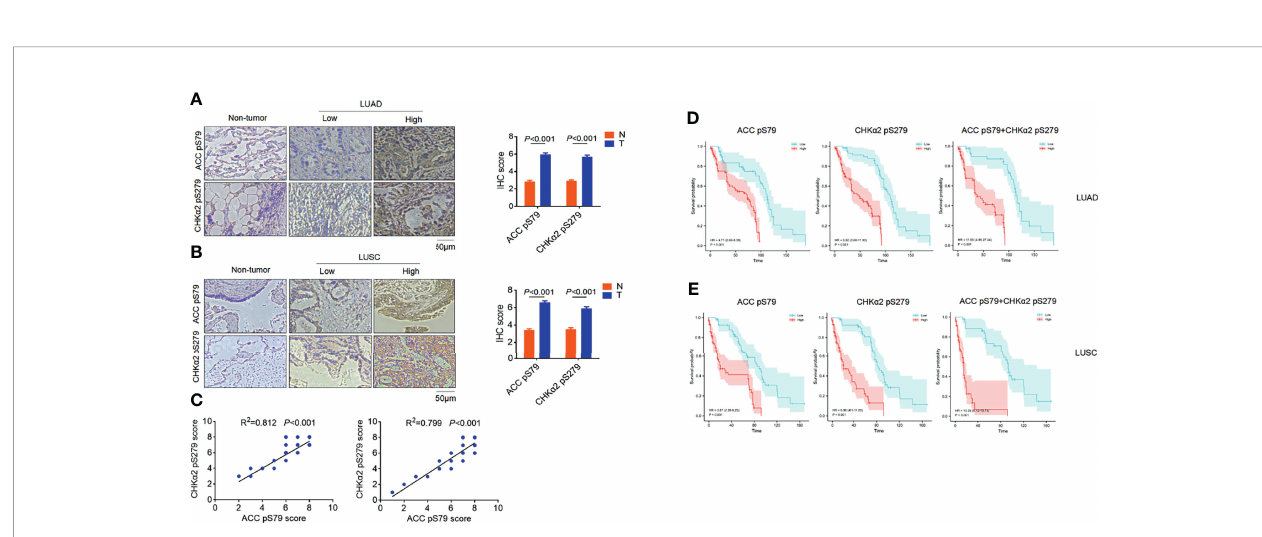
FIGURE 4 | ACC pS79 and CHK a 2 pS279 levels are positively correlated with poor prognosis in NSCLC patients. (A, B) Representative IHC staining of ACC pS79 and CHK a 2 pS279 in LUAD, LUSC, and adjacent non-tumor tissues (left panel). The expression levels of ACC pS79 and CHK a 2 pS279 in the NSCLC and adjacent non-tumor tissues were quanti fi ed (right panel). (C) The correlations between the expression levels of ACC pS79 and CHK a 2 pS279 in LUAD (left panel) and LUSC (right panel) specimens were calculated. (D) Analysis of the expression levels of ACC pS79, CHK a 2 pS279, and combined ACC pS79 and CHK a 2 pS279 with the prognosis of LUAD patients was performed. (E) Analysis of the expression levels of ACC pS79, CHK a 2 pS279, and combined ACC pS79 and CHK a 2 pS279 with the prognosis of LUSC patients was